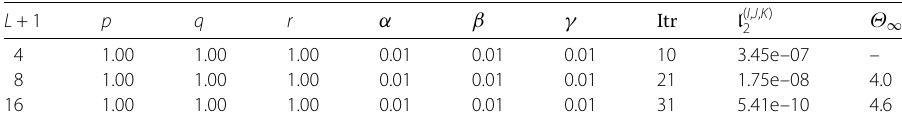
Table 5a Errors and order for UM-FOCS in Example 5.5 at (cid:2) = 1